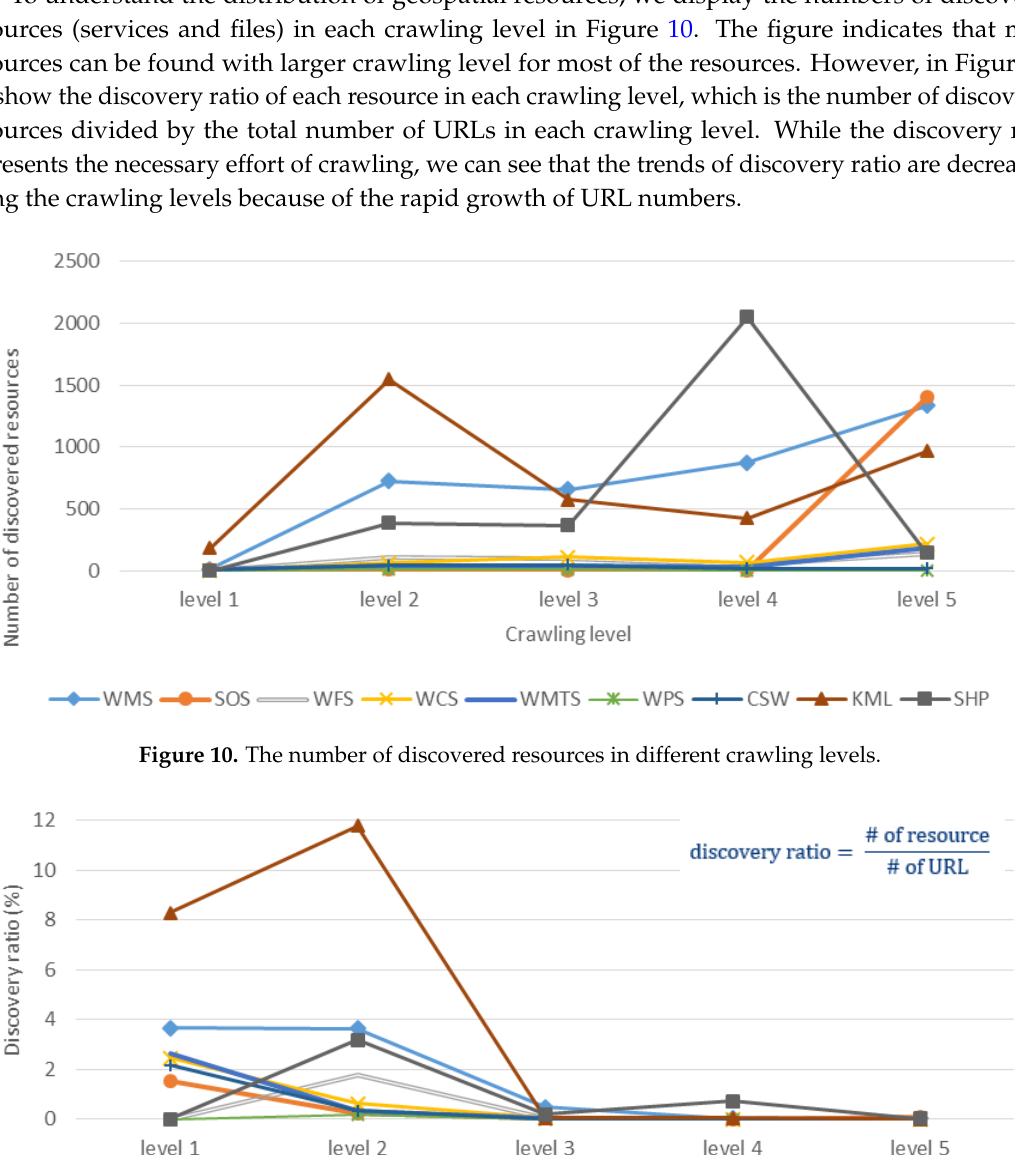
Figure 12. Performance comparison between standalone and parallel processing. 6. GeoHub—A GeoWeb Search Engine Prototype As the WWW has Web search engines addressing web resource discovery issues, we envision that the GeoWeb also requires GeoWeb search engines for users to efficiently find GeoWeb resources. In this section, we demonstrate the prototype of the proposed GeoWeb search engine, GeoHub , which currently allows users to search for OWSs. With the GeoHub user interface, as shown in Figure 13, users can use the keyword search to find the OWSs of their interests. In order to achieve keyword search, the GeoWeb search engine needs a database to manage the metadata that are used as the information for the query operation.